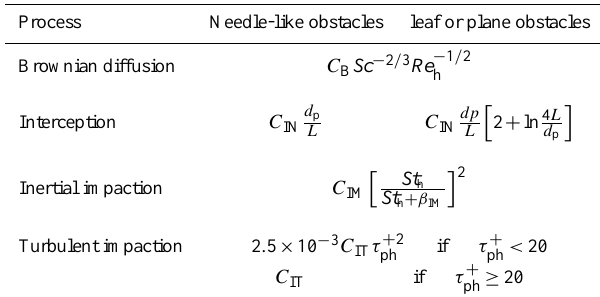
Table 1. Parameterization of the deposition efficiencies over vege-